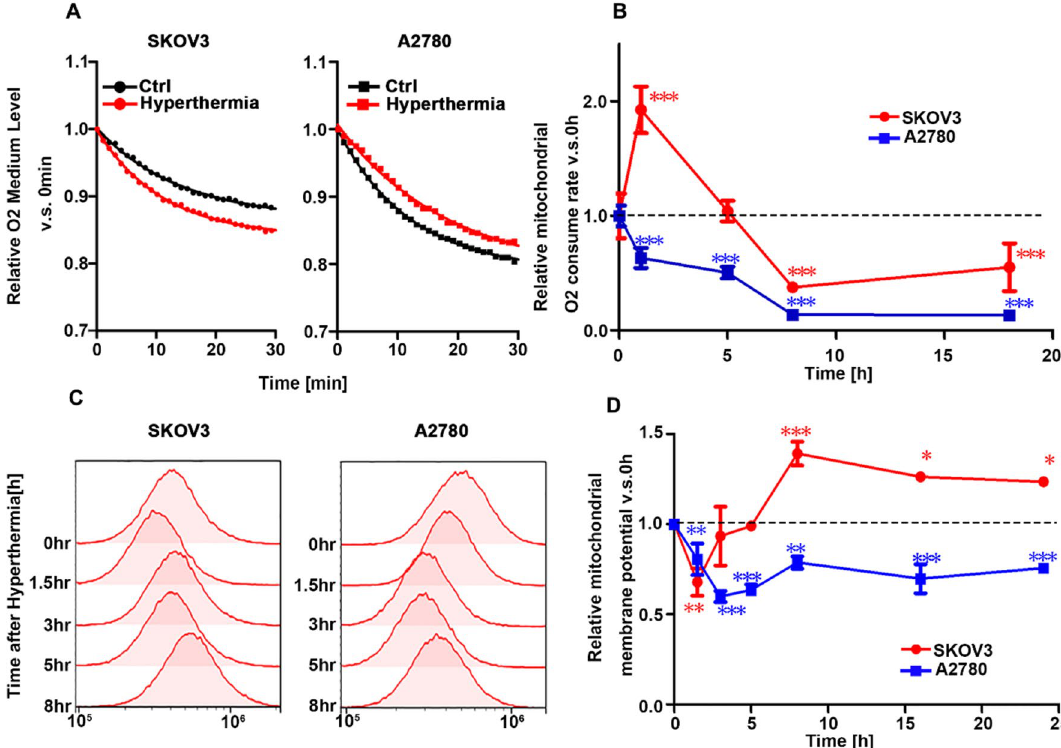
Figure 5. O 2 consumption and mitochondrial membrane activity of A2780 and SKOV3 cells treated with hyperthermia. ( A ) Relative amount of O 2 in the medium vs. time 0. A2780 and SKOV3 cells were treated with hyperthermia. ( B ) Time profiles of O 2 consumption rates in A2780 and SKOV3 cells treated with hyperthermia. ( C ) Mitochondrial membrane activities in heated A2780 and SKOV3 cells stained with Rhodamine 123 were measured using flow cytometry. ( D ) Time profiles of membrane potentials of mitochondria in A2780 and SKOV3 cells treated with hyperthermia (0 to 1 h). Mean ± S.D. (n = 3). *P < 0.05;**P < 0.01; ***P < 0.001 (vs 0 h).